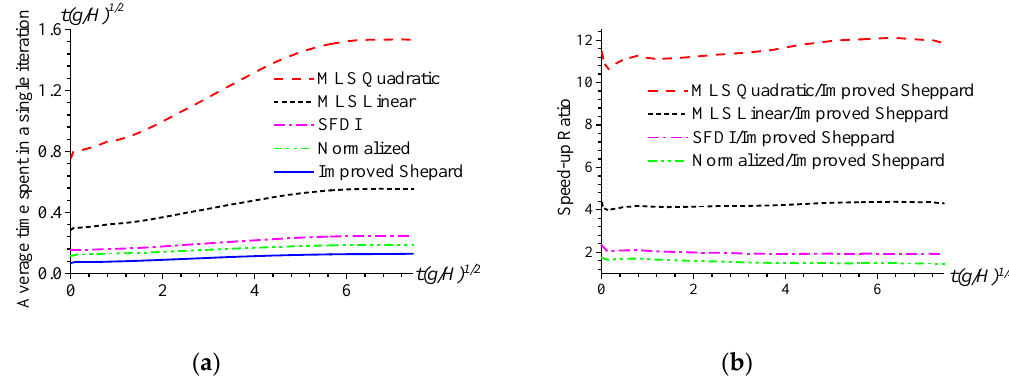
Figure 9. Comparison of computational efficiency between the improved Shepard and other methods for dam-breaking. ( a )Average time spent in a single iteration, ( b ) a sped-up comparison.